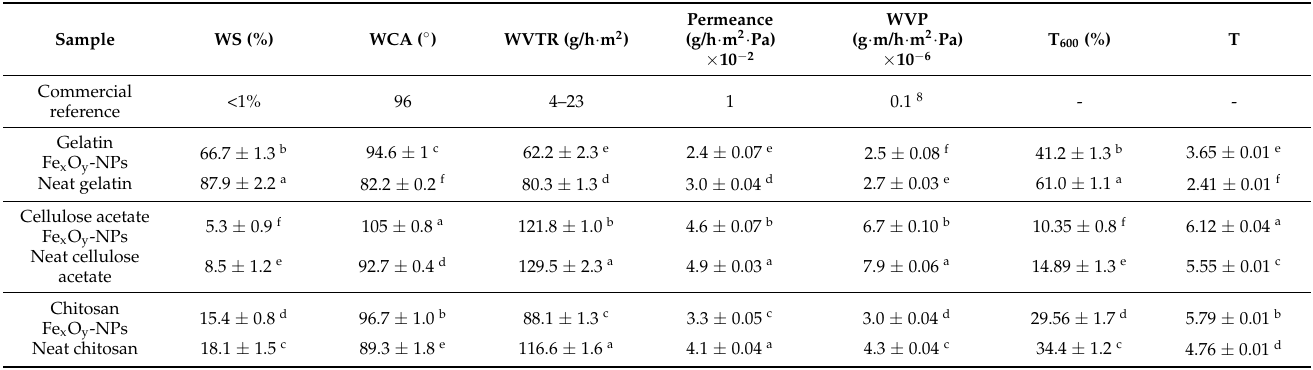
Table 1. Physicochemical and optical values of the different films embedded with Fe x O y nanoparticles (1.0 %). Neat films (gelatin-based, cellulose acetate-based, and chitosan-based films) without Fe x O y nanoparticles incorporated were used as references. The parameters of a commercial material based on polyethylene were included as reference. Different superscript letters (a–f) for each column indicate heterogeneity of variances ( p <